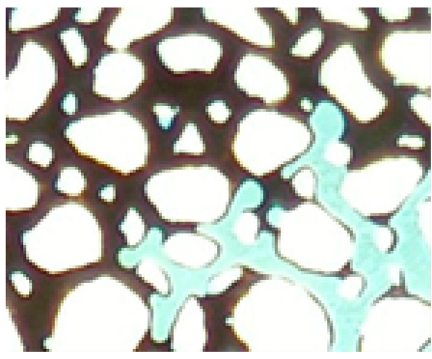
Fig. 14 Oil–polymer solution interface in sandstone flow pattern dur- ing polymer flooding (polymer solution in light blue and oil in brown